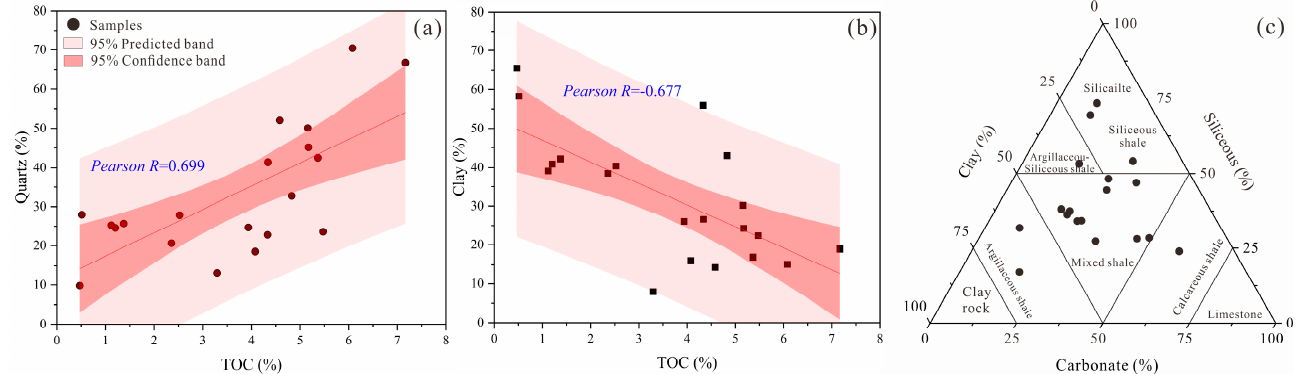
Figure 2. Correlation between TOC content and quartz ( a ) and clay ( b ); three-end diagram for lithofacies classification based on mineral compositions ( c ).